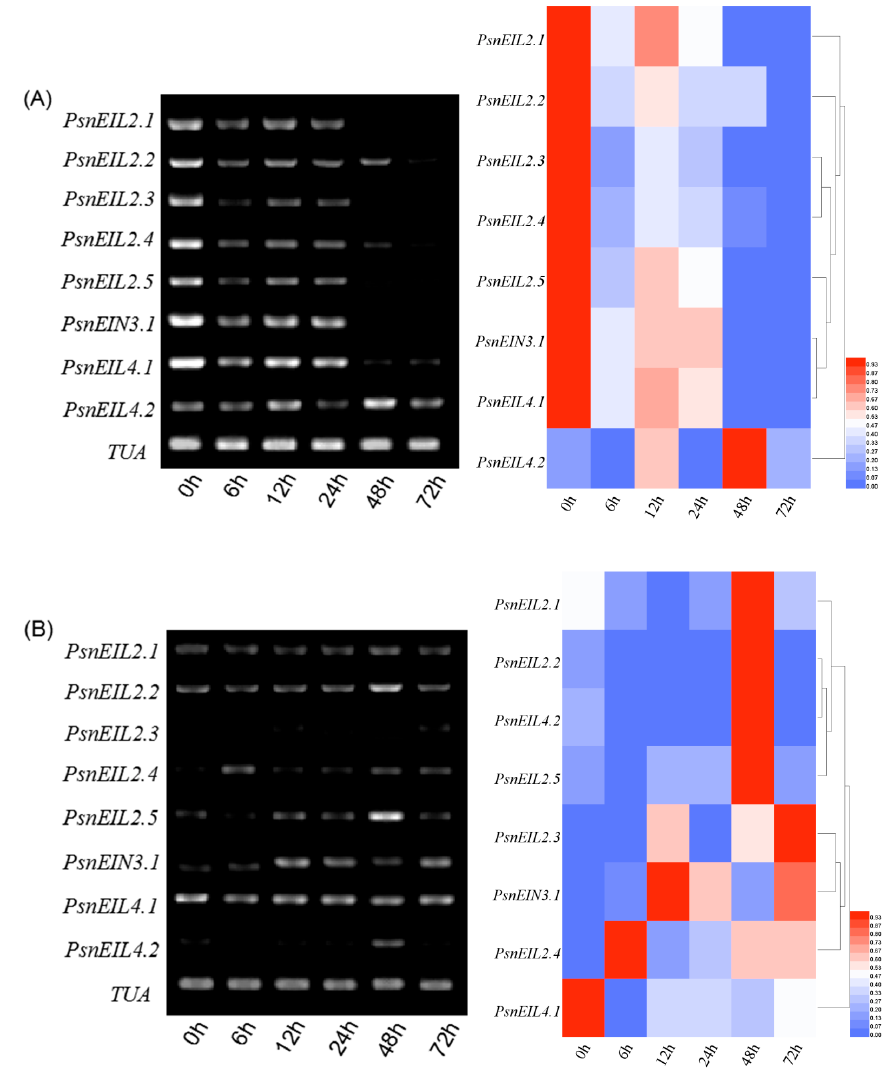
Figure 13. EIN3/EIL gene expression patterns of Populus × xiaohei under NaHCO 3 stress. ( A ) Root. ( B ) Leaf. ( B ) 3.3.7. Response of PsnEIN3/EIL Genes to PEG in Populus × xiaohei